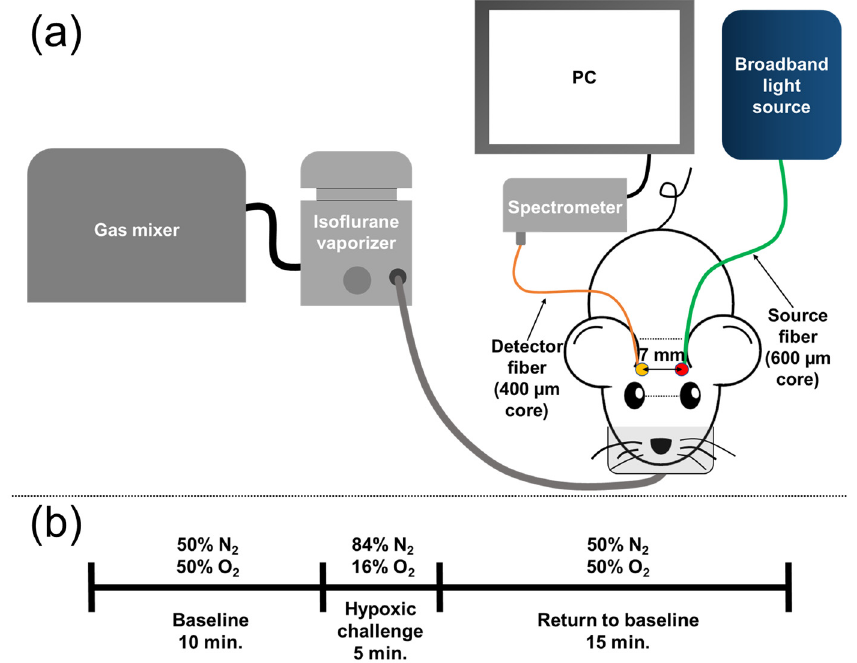
Figure 1. ( a ) Schematic of the animal experimental setup, ( b ) protocol of gas